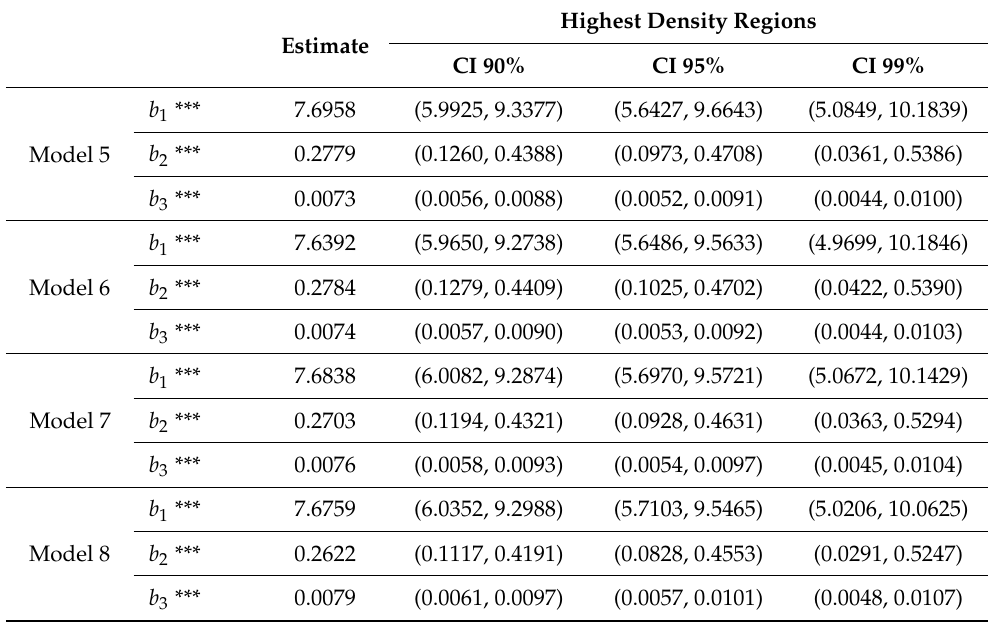
Table 7. Results for Model 5 to Model 8 (data from 1959 to 2019).